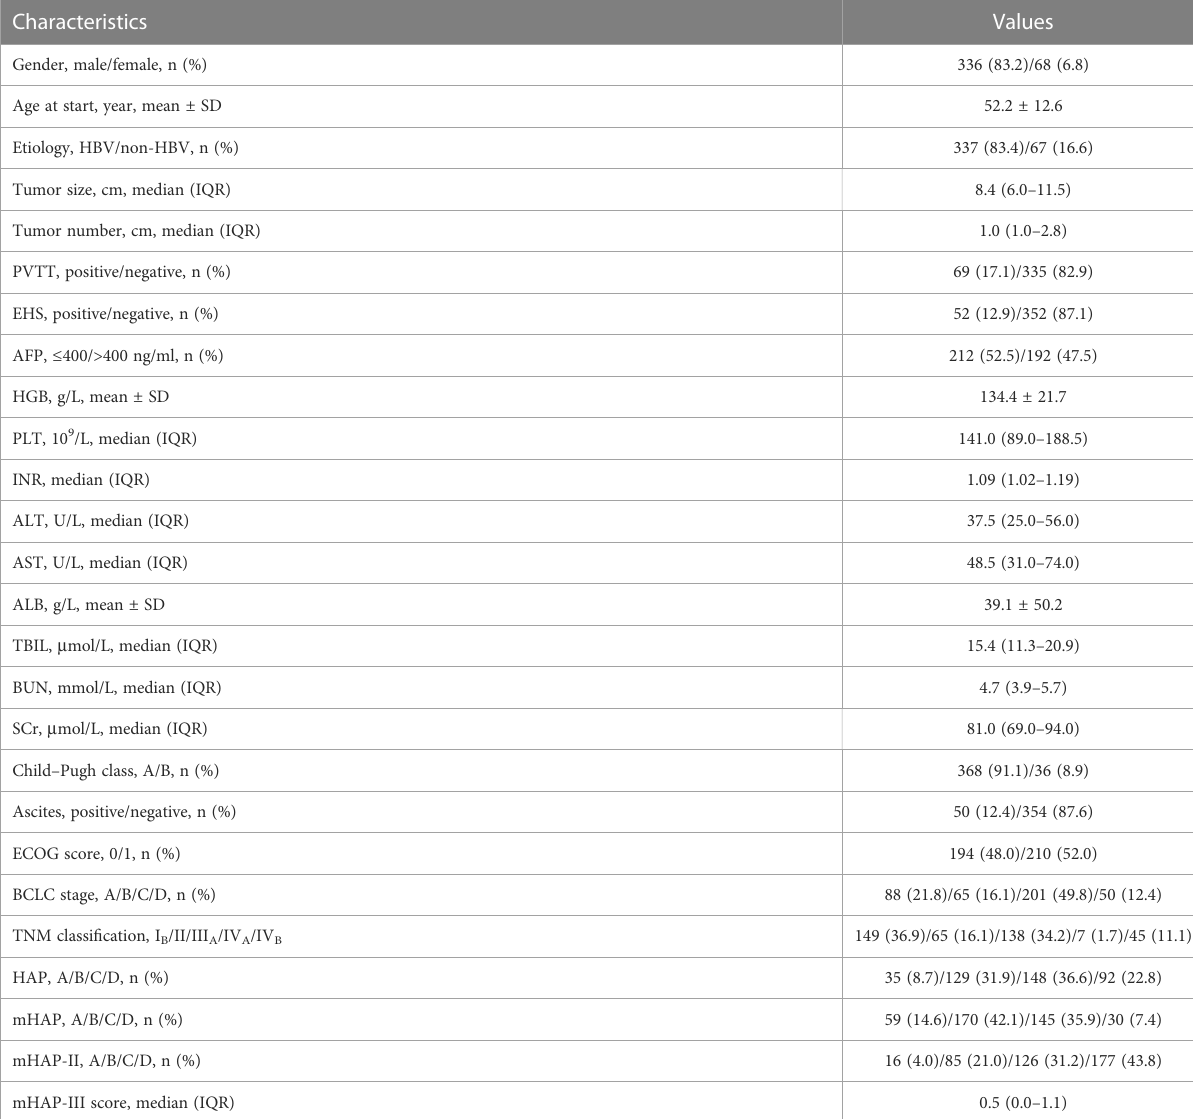
TABLE 2 Baseline characteristics for the study patients (n = 404).